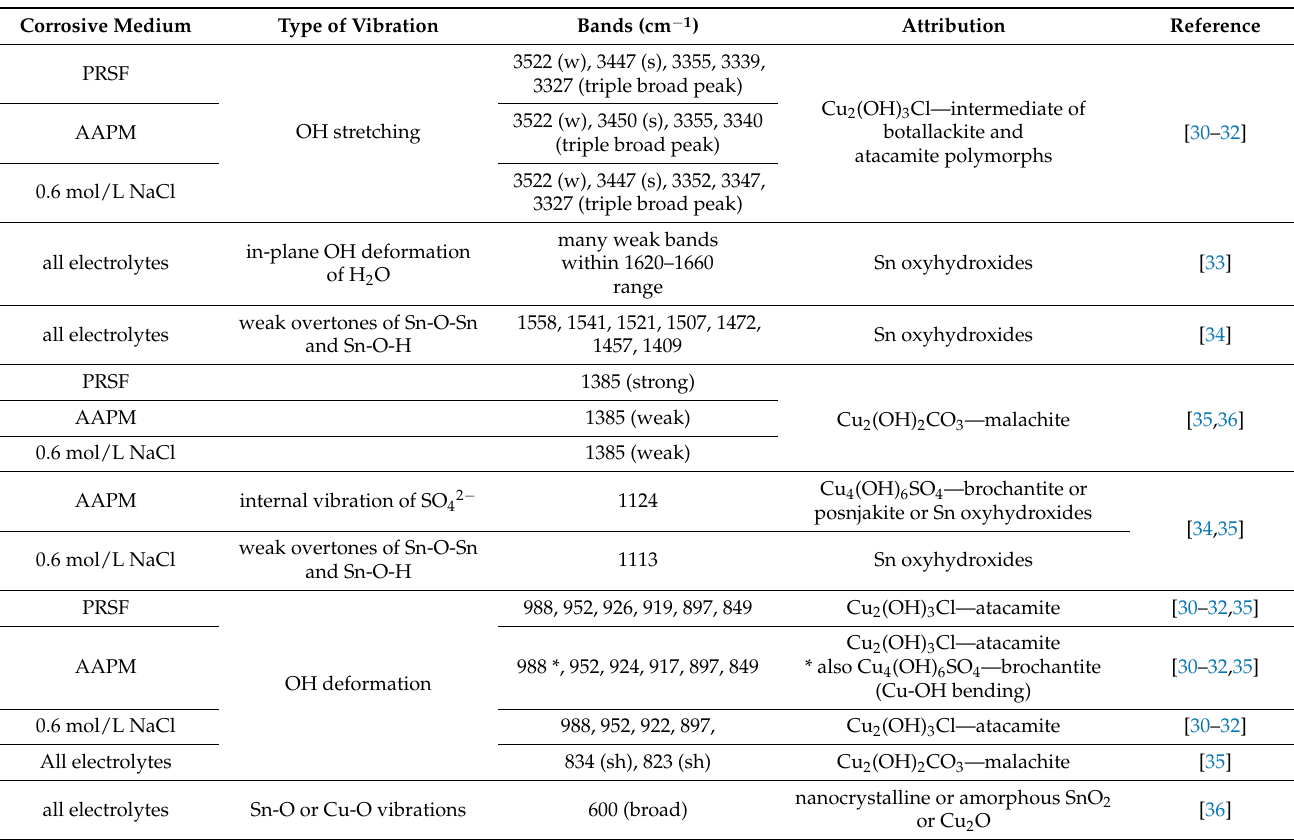
Figure 7. FTIR spectra of corrosion products collected from TB electrode surfaces at the end of anodic sweeps (OCP+ 0.6 V) in 0.6 mol/L NaCl, AAPM and PRSF electrolytes: ( a ) Bands 4000–3000 cm − 1 , ( b ) bands 1700–1300 cm − 1 , ( c ) bands 1270–770 cm − 1 and ( d ) bands 650–400 cm − 1 . The two powder samples (AAPM and PRSF patinas) were light green, and the third (0.6 M NaCl patina) was whitish. The most important vibrational patterns are summarized in Table 4. Table 4. Observed bands in FTIR spectra of homogenized patina powder samples after anodic polarization in PRSF, AAPM and 0.6 mol/L NaCl.